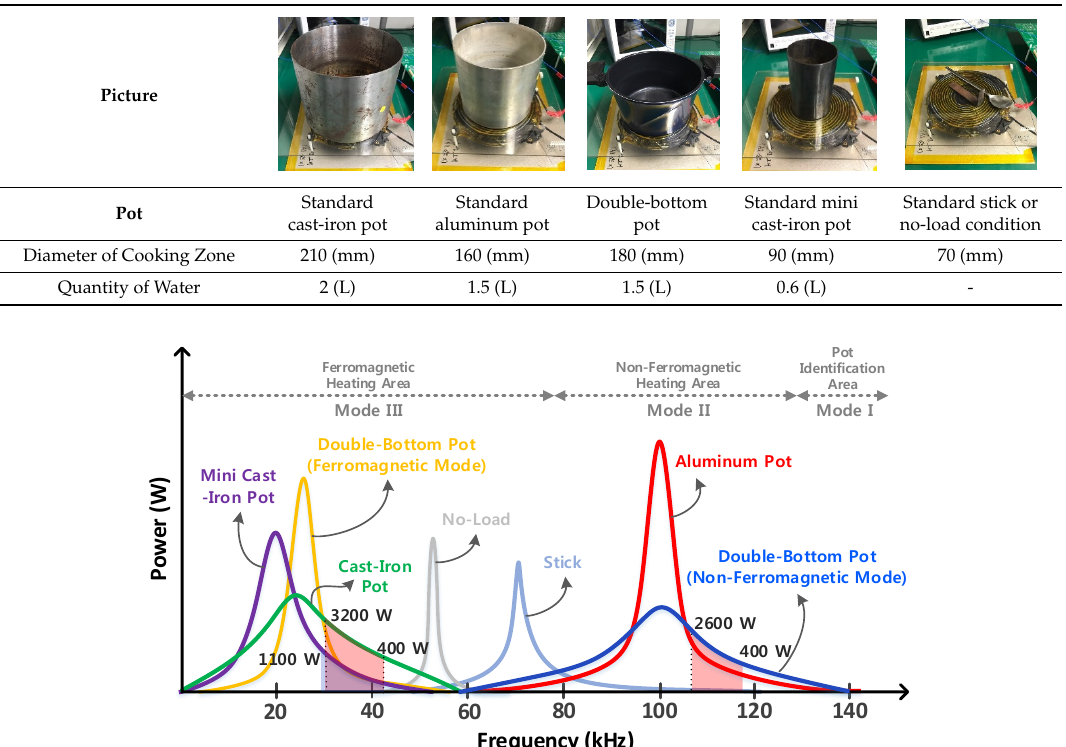
Table 3. Pot type and amount of water for all-metal domestic IH system load.